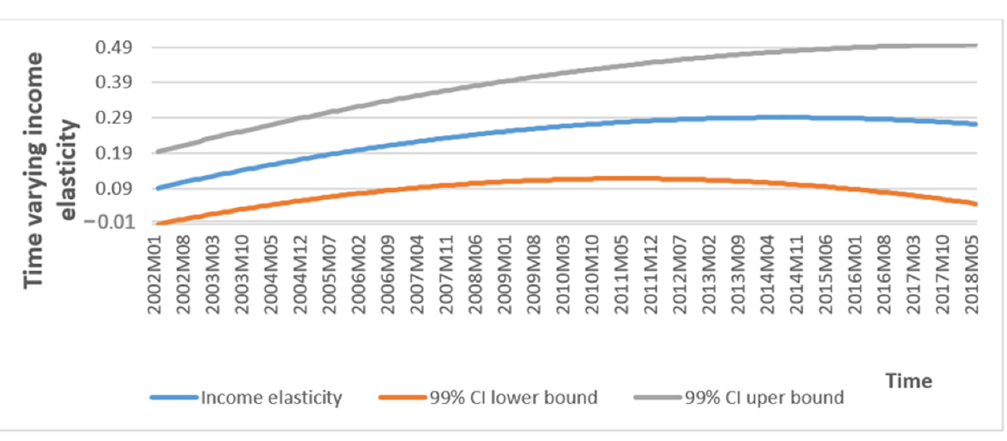
Figure 3. Time varying income elasticity: TVCC result.